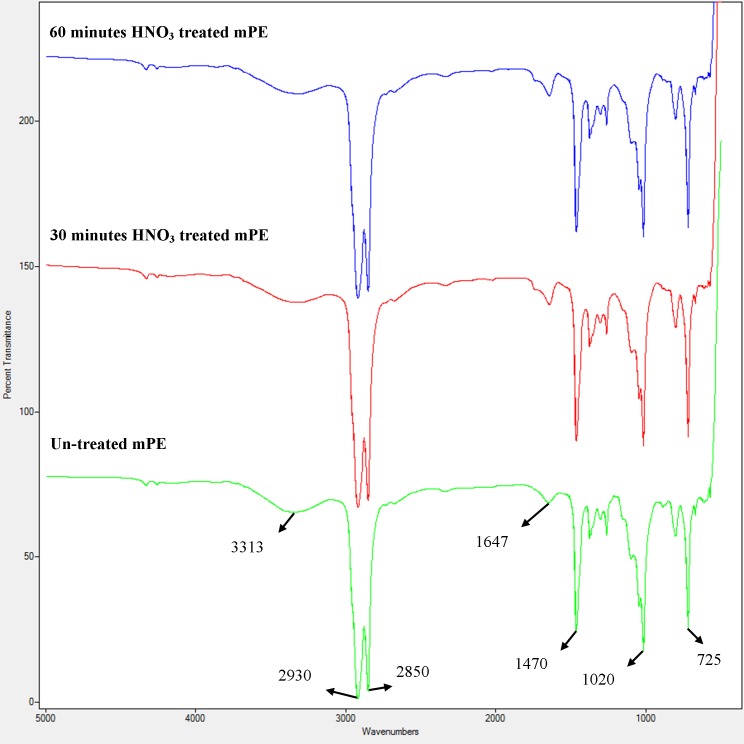
A representative FTIR spectra of untreated and HNO3 treated mPE.